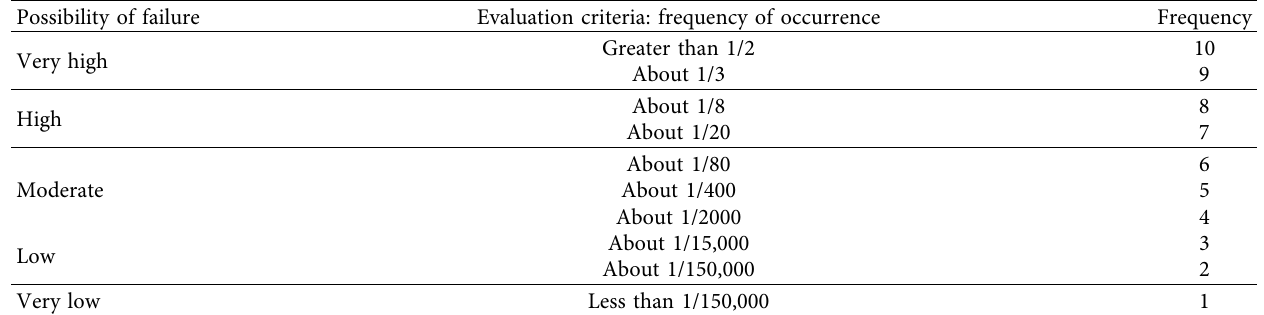
Table 12: Frequency ( O ) scoring criteria.